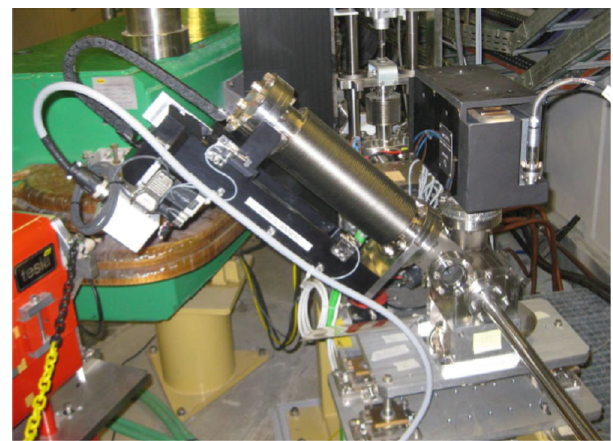
FIG. 14. Picture of the installation of the SwissFEL WSC at FERMI. The WSC in-vacuum hardware is placed in the linac hall just after the dipole of the FERMI high energy